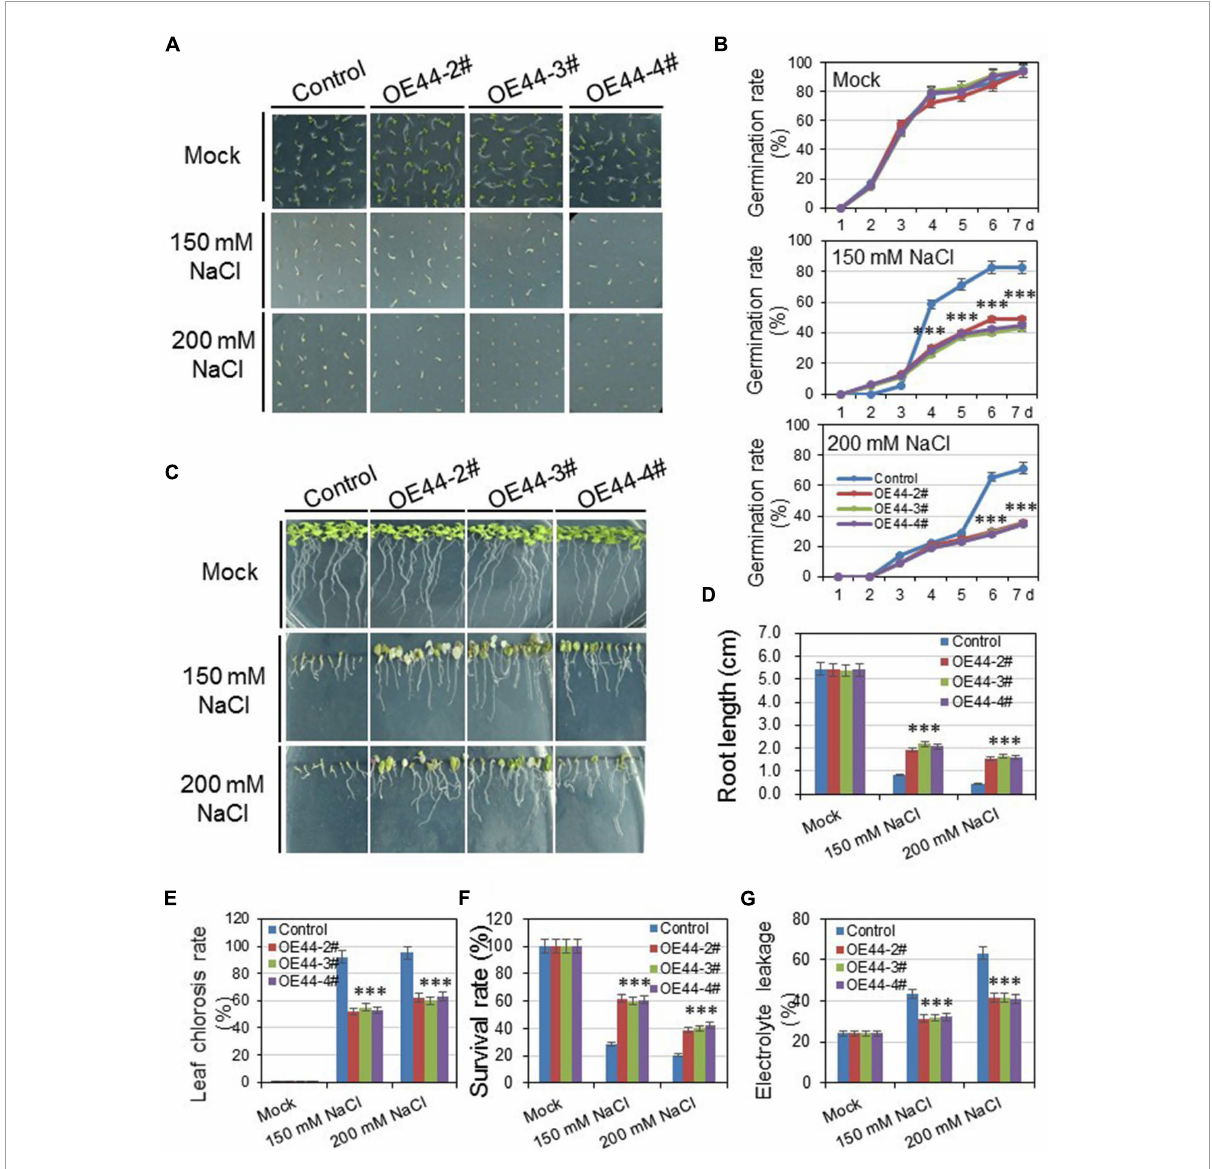
FIGURE6 Overexpression of HcWRKY44 in Arabidopsis enhanced tolerance to salinity stress. (A,B) The seed germination rate was comparably analyzed between the HcWRKY44 transgenic lines and control lines on the 150 mM and 200 mM NaCl plates. The images were photographed at 7 d after germination. (C–F) The root length, leaf chlorosis rate, survival rate and electrolyte leakage were comparably analyzed between HcWRKY44 transgenic and control lines after treated with 150 and 200 mM NaCl. All the values represent the means of three independent biological replicates; error bars indicate the SD. ∗ P < 0.05 and ∗∗∗ P < 0.01 represented the significant differences by Student’s t -test,